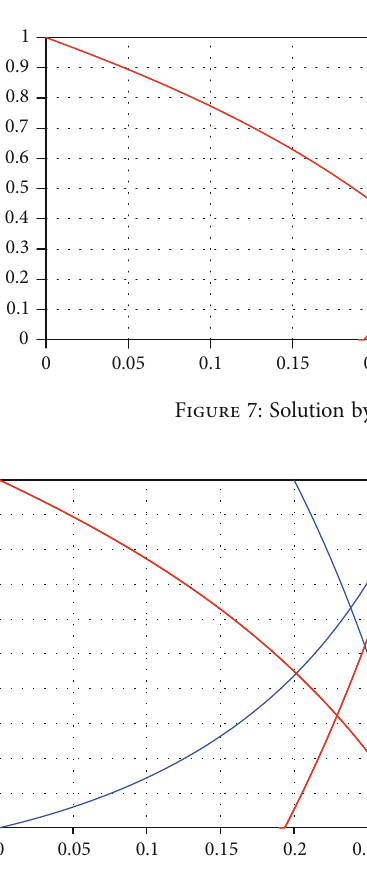
Figure 8: The graph of the solution obtained in Example